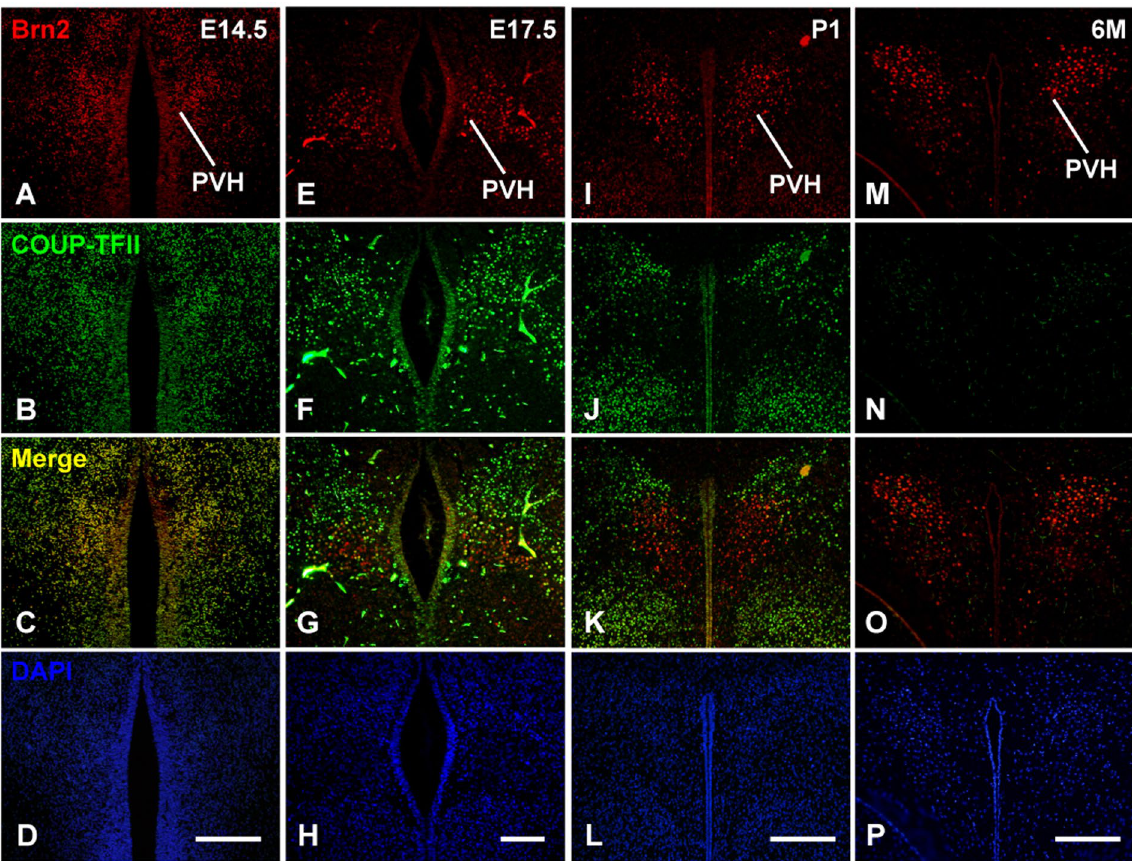
Figure 4. COUP-TFII is co-expressed with Brn2 in the early differentiating PVH neurons, but not in the late differentiating PVH neurons and the mature PVH neurons. ( A – D ) Colocalization of Brn2 (red) and COUP- TFII (green) in the early differentiating PVH neurons at E14.5. ( E – H ) Expression of Brn2 and COUP-TFII in the differentiating PVH neurons at E17.5. ( I – L ) Expression of Brn2 and COUP-TFII in the late differentiating PVH neurons at P1. ( M – P ) Expression of Brn2 and COUP-TFII in the mature PVH neurons at 6 M. PVH, paraventricular nucleus of hypothalamus. Scale bars, ( A – D , I – L , M – P ) 200 μ m; ( E – H ) 100 μ